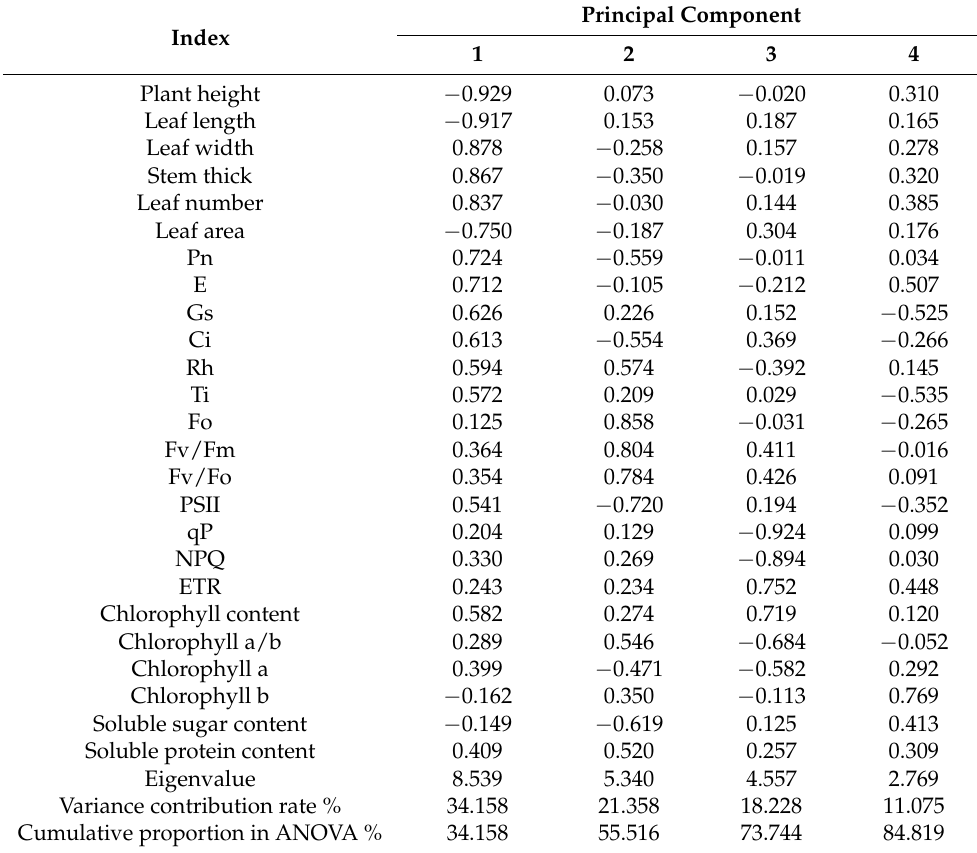
Table 4. On 25 photosynthetic physiological indices from 10 Cypripedium samples, principal com- ponent analysis was performed. Other indices could be effectively replaced by the first four major components, the table shows the load matrix and variance contribution rate.